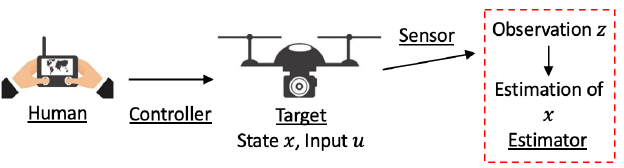
Figure 1. The problem of estimating a human-maneuvered target from